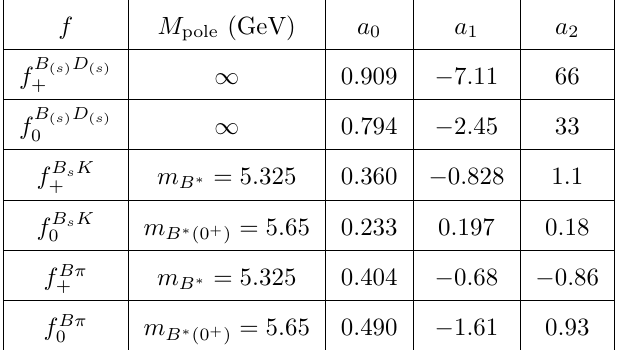
(cid:25) , B ( s ) D ( s ) and B s K ! ! !